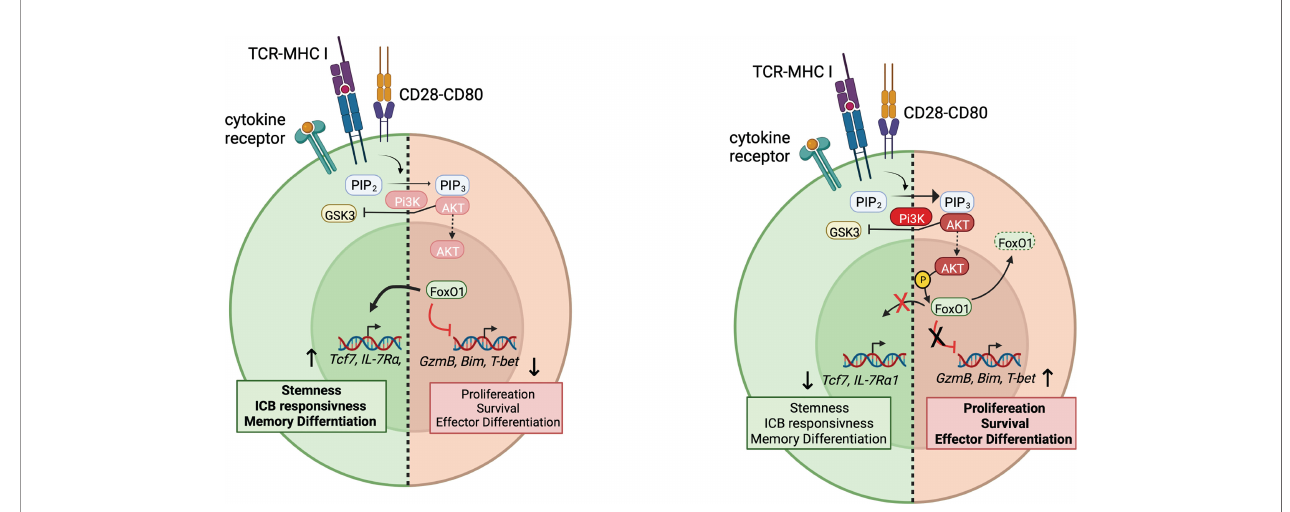
FIGURE 2 | PI3K and regulation of stem-like pTex cells. Right: Upon T cell activation, PI3K generates PIP 3 , which recruits AKT, leading to its activation at the plasma membrane, which then leads to the phosphorylation and nuclear exclusion of FoxO1 and BACH2. Downstream genes associated with stemness and memory differentiation, such as Tcf7 are no longer induced by FoxO1, whereas effector genes such as T-bet and GranzymeB, usually suppressed by FoxO1, can be transduced. How CD226 integrates in this model is not yet clear. Left: Under conditions of low PI3K activity, FoxO1 remains active, and Tcf7 and other genes associated with pTex cells are